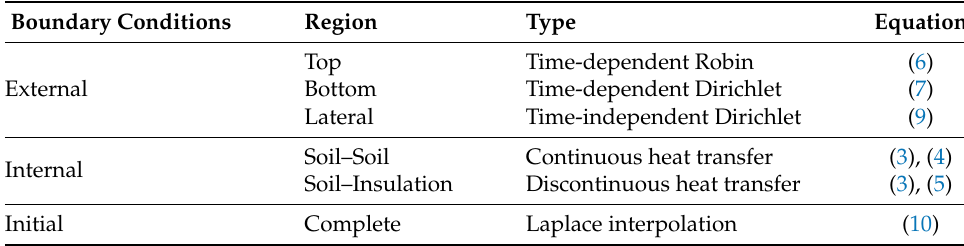
Table 1. Summary of the GES model presented in Section 2 regarding boundary conditions and their specific region, type as well as the corresponding